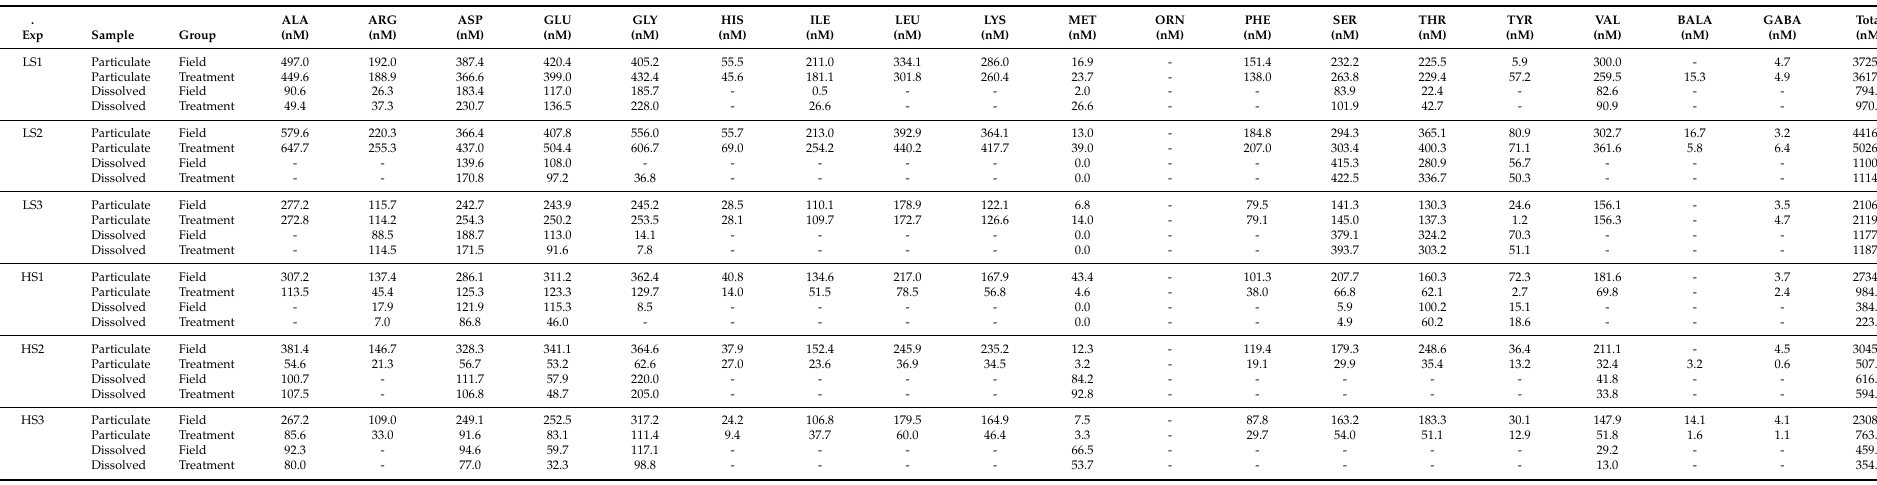
Table 4. Amino acid concentrations in the field and in treatment. Abbreviations: ALA: alanine; ARG: arginine; ASP: aspartic acid; GLU: glutamic acid; GLY: Glycine; HIS: histidine; ILE: isoleucine; LEU: leucine; LYS: lysine; MET: methionine; ORN: ornithine; PHE: phenylalanine; SER: serine; THR: threonine; TYR: tyrosine; VAL: valine; BALA: β -alanine; GABA: γ -aminobutyric acid; LS: low-salinity; HS: high-salinity. .